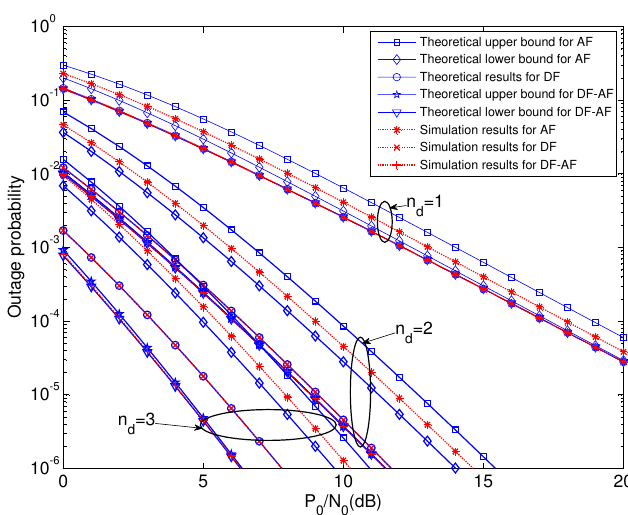
code when all 3